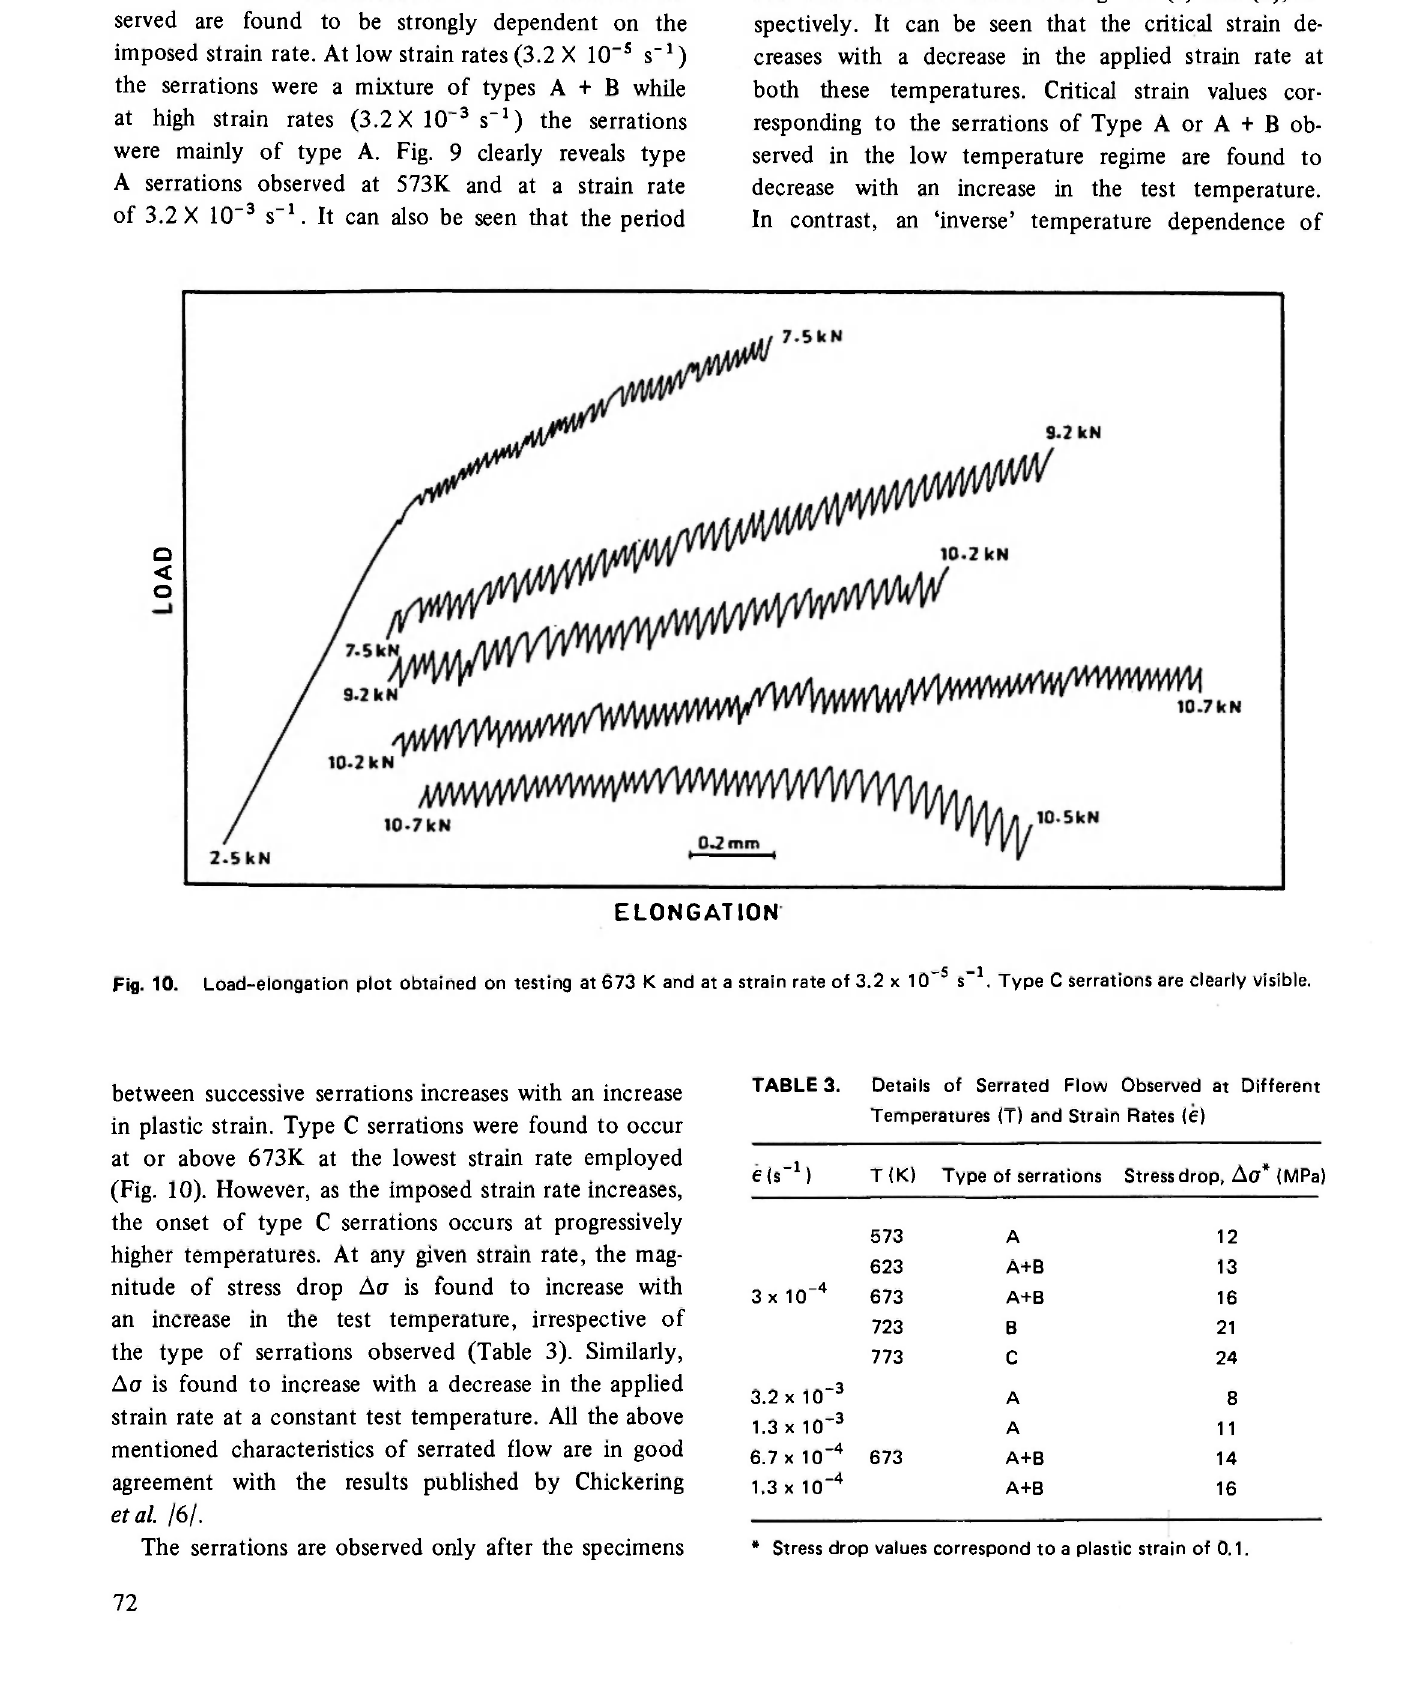
Fig. 10. Load-elongation plot obtained on testing at 673 Κ and at a strain rate of 3.2 χ 1CT 5 s -1 . Type C serrations are clearly visible.